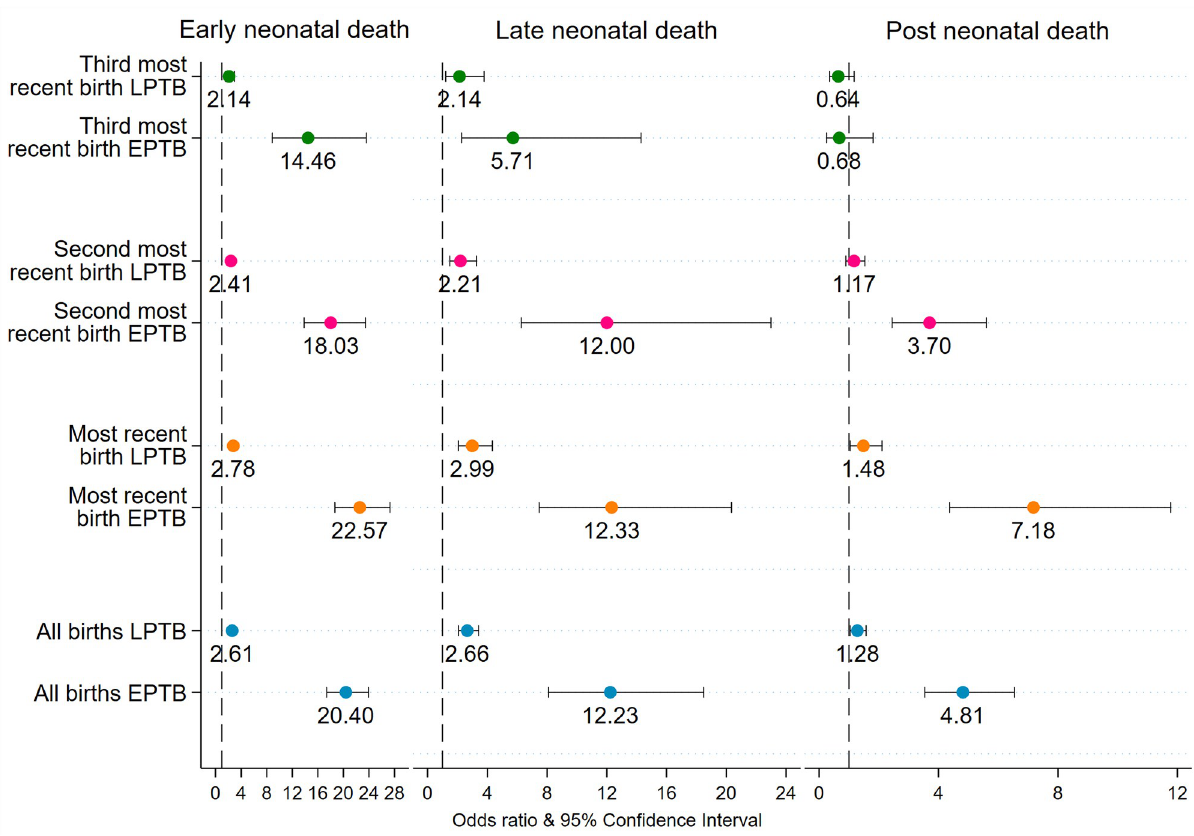
Fig 4. Adjusted odds ratio of ENND, LNND, and PNND for early preterm birth (EPTB) and late preterm birth (LPTB), NFHS-4, 2015–16. Note. 1. Odds ratios are significant at p < 0.05. ENND Early Neonatal Death, LNND Late Neonatal Death, PNND Post Neonatal Death. Odds ratio are adjusted for birth order, index child c-section, index birth wanted, sex of child mother’s age at conception, mother’s height, mother’s schooling, caste, religion, wealth quintiles, urban-rural residence, and state-region.